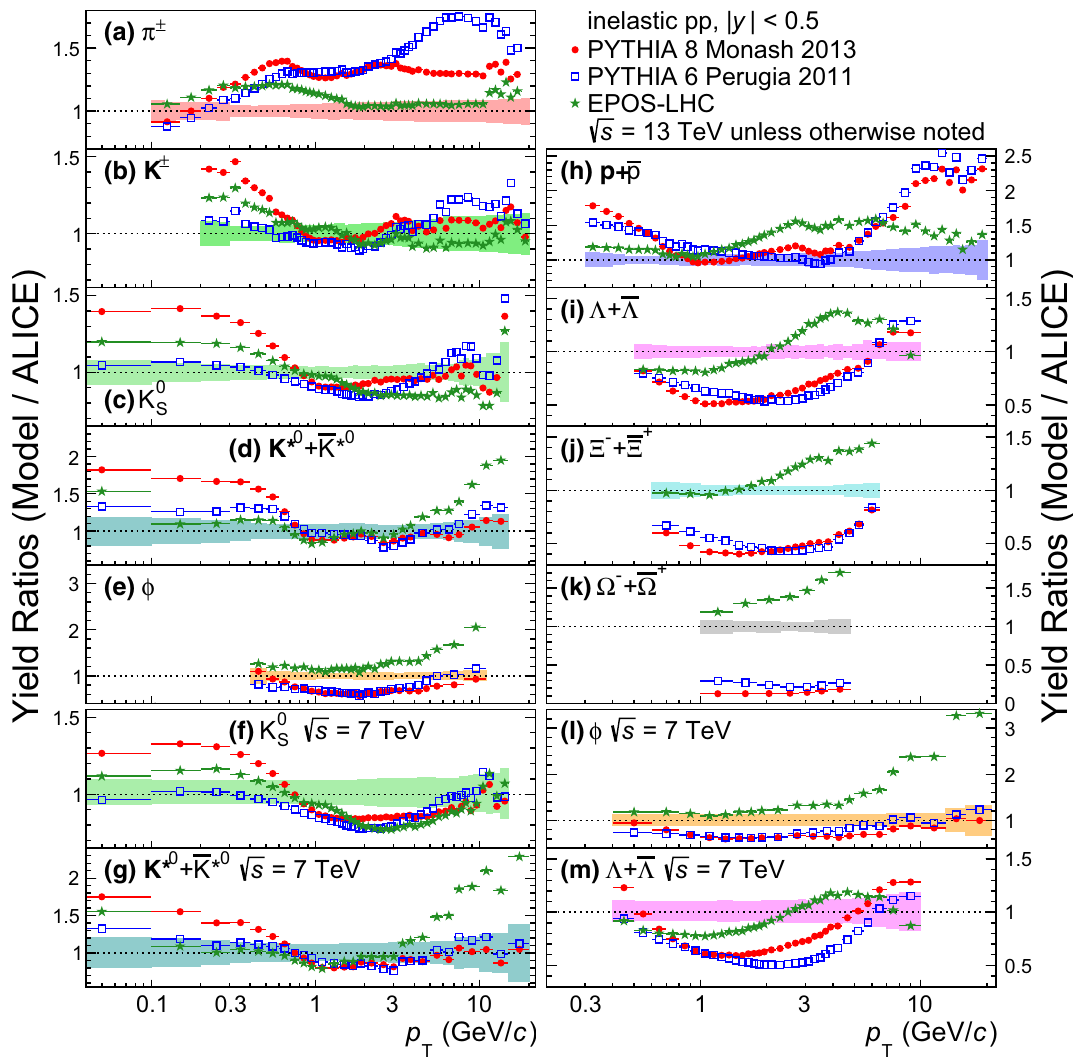
√ s = 13 and 7 TeV. The total √ s = 7 TeV are